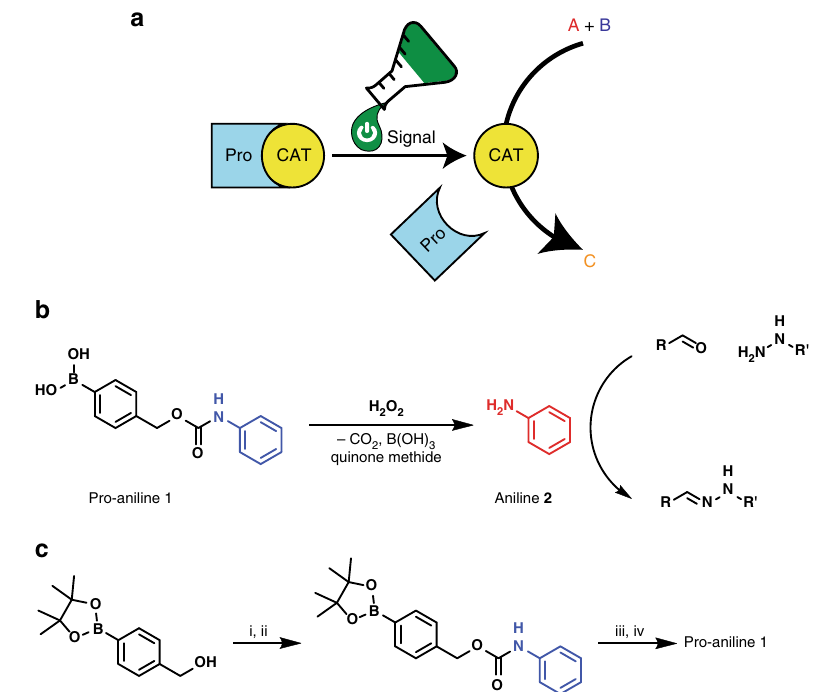
Fig. 1 Design and synthesis of the protected catalyst. a Schematic representation of the activation of a protected catalyst and subsequent catalysis of a chemical reaction. b The pro-catalyst pro-aniline 1 and the chemical signal H 2 O 2 react to release the organocatalyst aniline 2 , which catalyses hydrazone formation between an aldehyde and a hydrazide. c Synthetic route for the synthesis of pro-aniline 1 , (i) K 2 CO 3 , triphosgene, 0 °C – room temperature, (ii) aniline 2 , NaHCO 3 , tetrahydrofuran, 0 °C – room temperature, (iii) NaIO 4 , ammonium acetate, room temperature, (iv) 1 M aqueous HCl. Total yield over two steps is